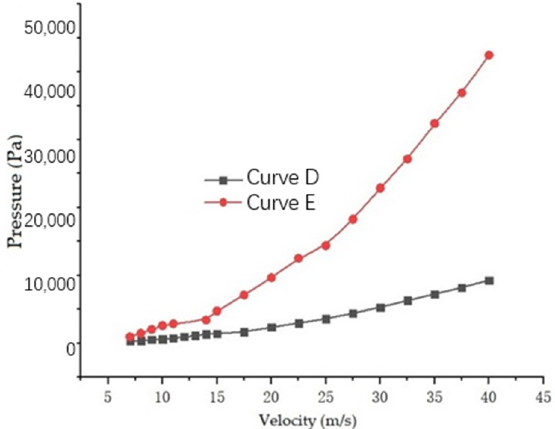
Figure 7. Impact air pressure–velocity curve.